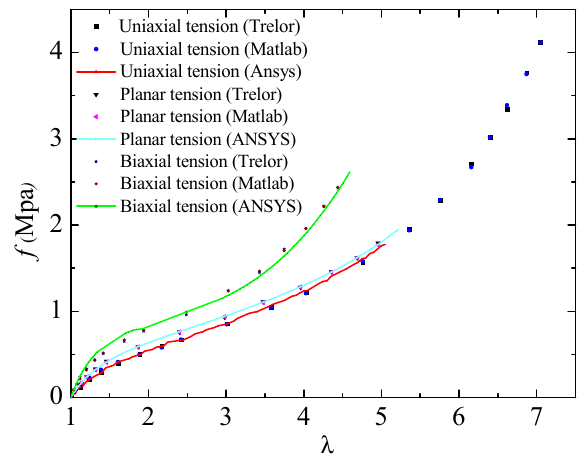
Figure 1. Verification of the determined parameters in Ogden model.